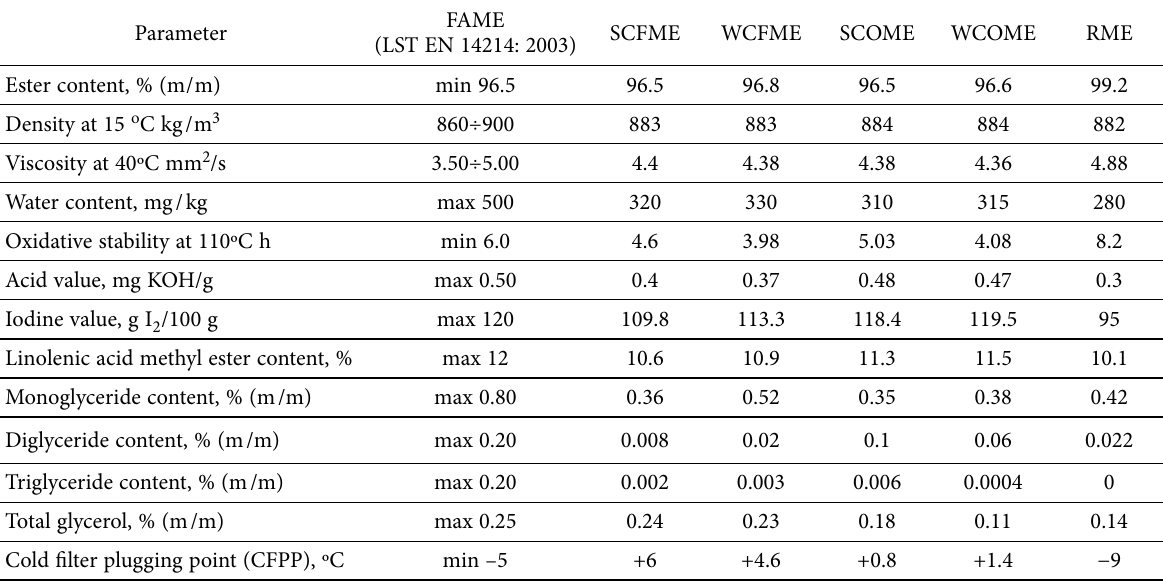
Table 2. The characteristics of various types of fatty acid methyl esters (FAME) and their compliance with the requirements of LST EN